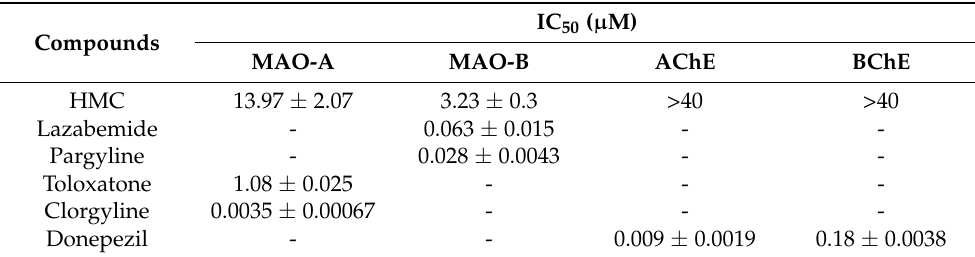
Figure 3. Time-dependency of HMC and MAO-B. The activities were measured after preincubation to the designated times, and were expressed as residual activities compared with control. Table 4. Inhibitory activities of HMC against the enzymes.